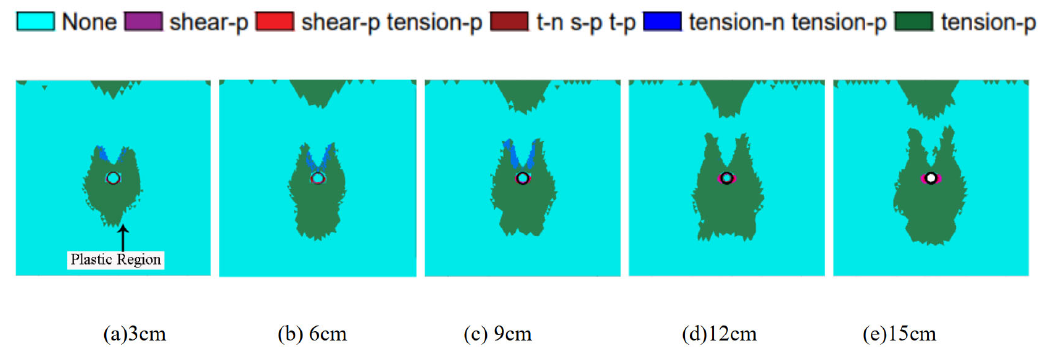
Figure 10. Plastic zone map of different drilling depths.